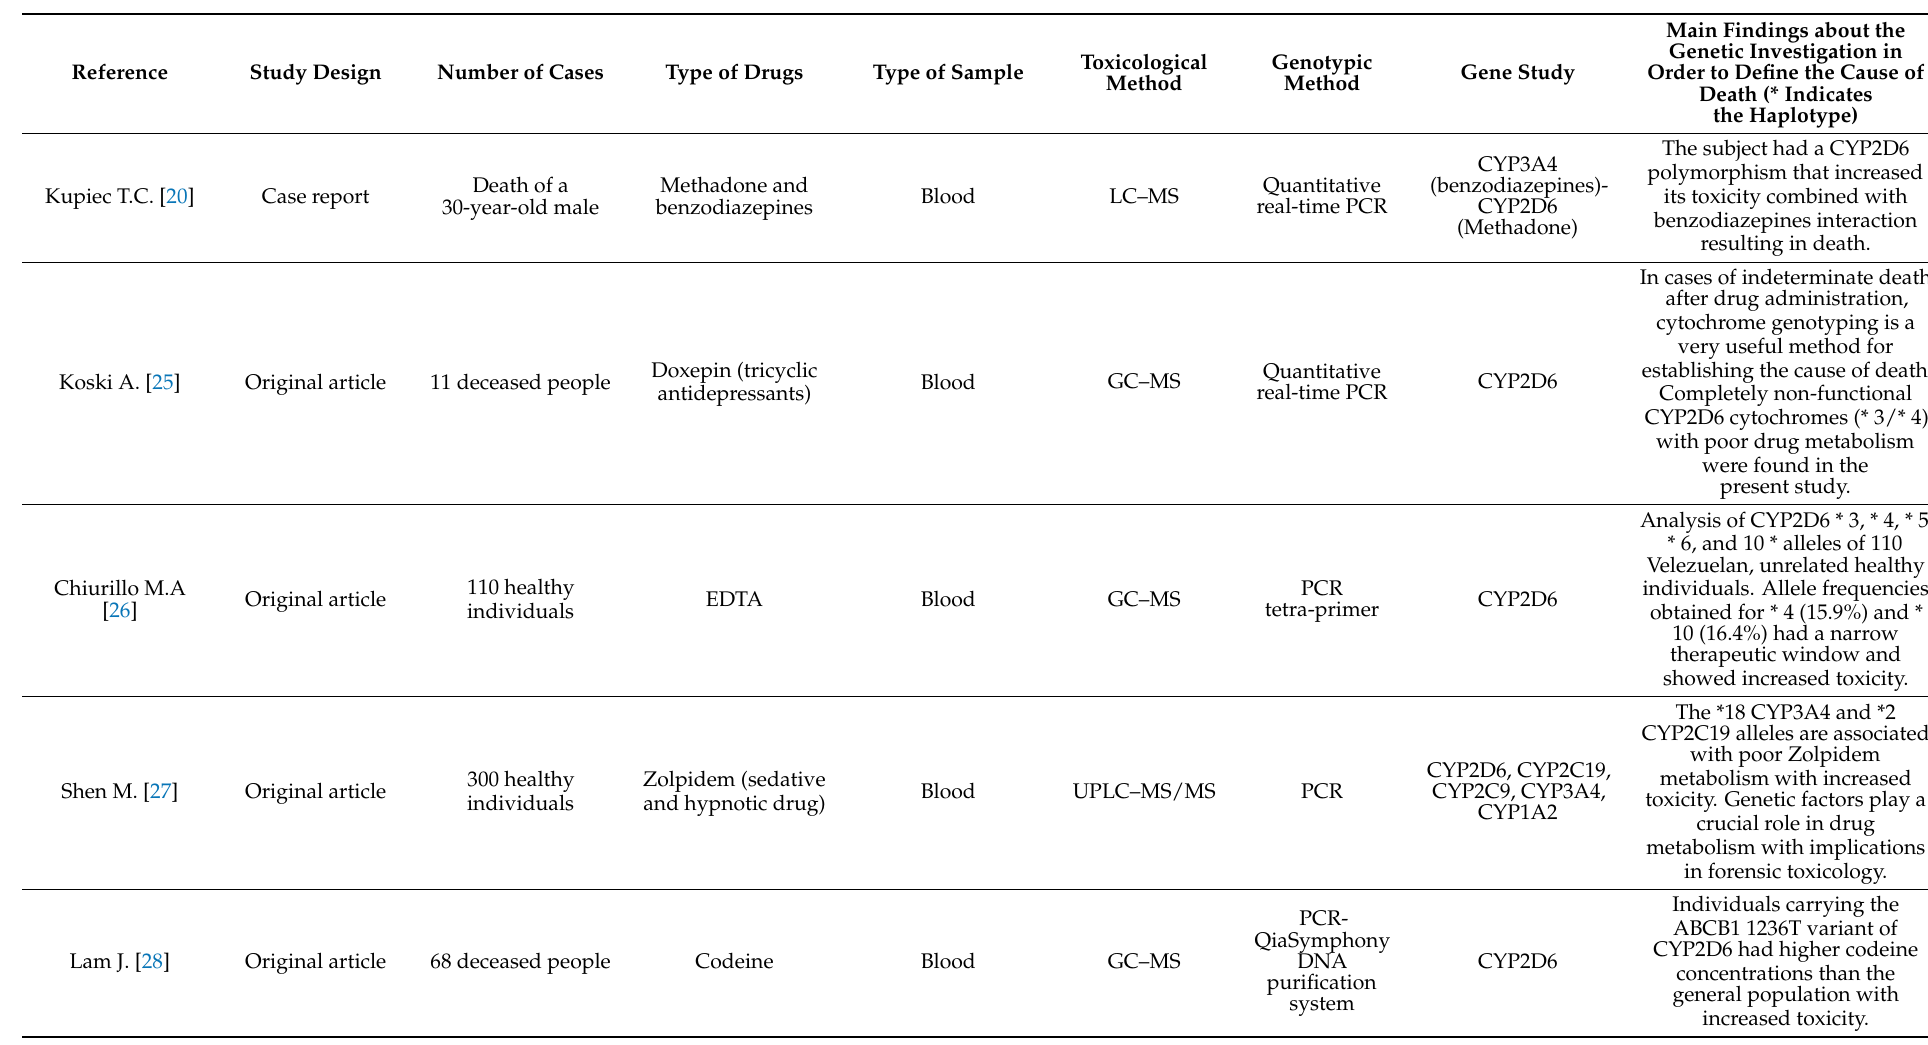
Table 2. Summary of the details of the systematic